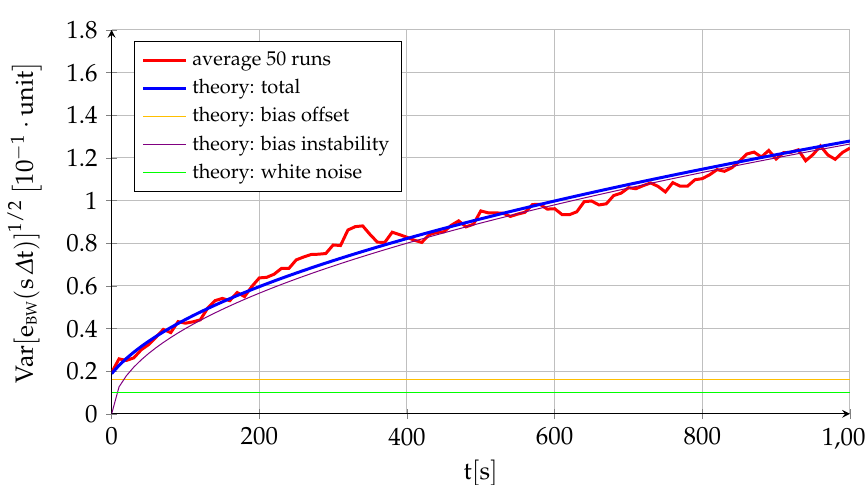
Figure 2. Propagation with time of sensor error mean.